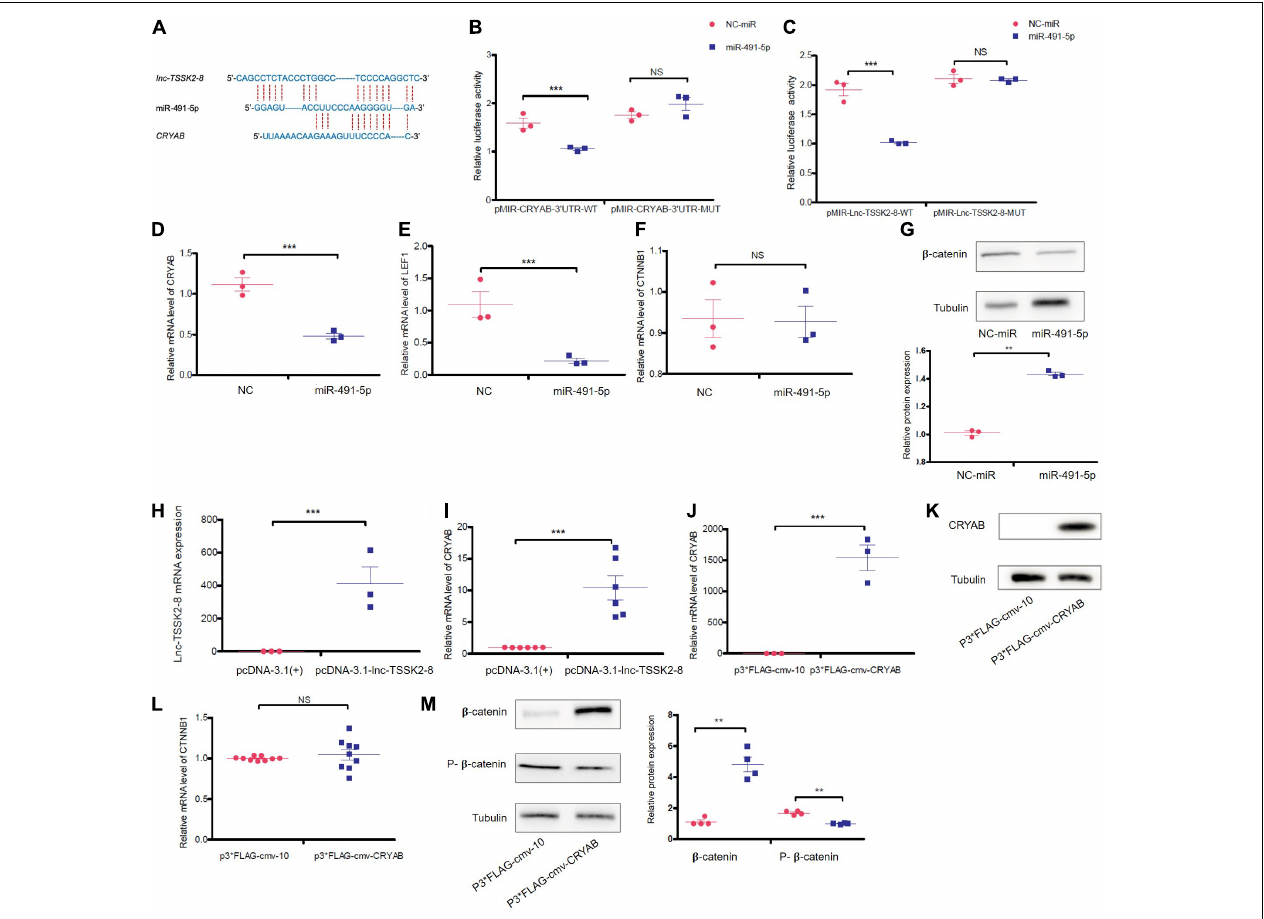
FIGURE 5 | lnc-TSSK2-8 activation promotes β -catenin stabilization through the miR-491-5p/ α -B-crystallin (CRYAB) axis. (A) The predicted miR-491-5p binding sites of lnc-TSSK2-8 and CRYAB 3 (cid:48) UTR. (B) The luciferase reporter assay we performed to confirm the interaction between miR-6721-5p and CRYAB 3 (cid:48) UTR (B) / lnc-TSSK2-8 (C) . (D) RT-qPCR analysis of CRYAB level in response to miR-491-5p overexpression. (E) RT-qPCR analysis of lymphoid enhancer-binding factor 1 (LEF1) level in response to miR-491-5p overexpression. (F) RT-qPCR analysis of β -catenin level in response to miR-491-5p overexpression. (G) Western blot (WB) analysis of protein expression of β -catenin in response to miR-491-5p overexpression. (H) Confirmation of lnc-TSSK2-8 overexpression with RT-qPCR. (I) RT-qPCR analysis of CRYAB level in response to lnc-TSSK2-8 overexpression. (J) Confirmation of CRYAB overexpression with RT-qPCR. (K) Confirmation of CRYAB overexpression with WB. (L) RT-qPCR analysis of β -catenin level in response to CRYAB overexpression. (M) WB analysis of β -catenin protein expression and phosphorylation in response to CRYAB overexpression. * p < 0.05, ** p < 0.001, ** p <